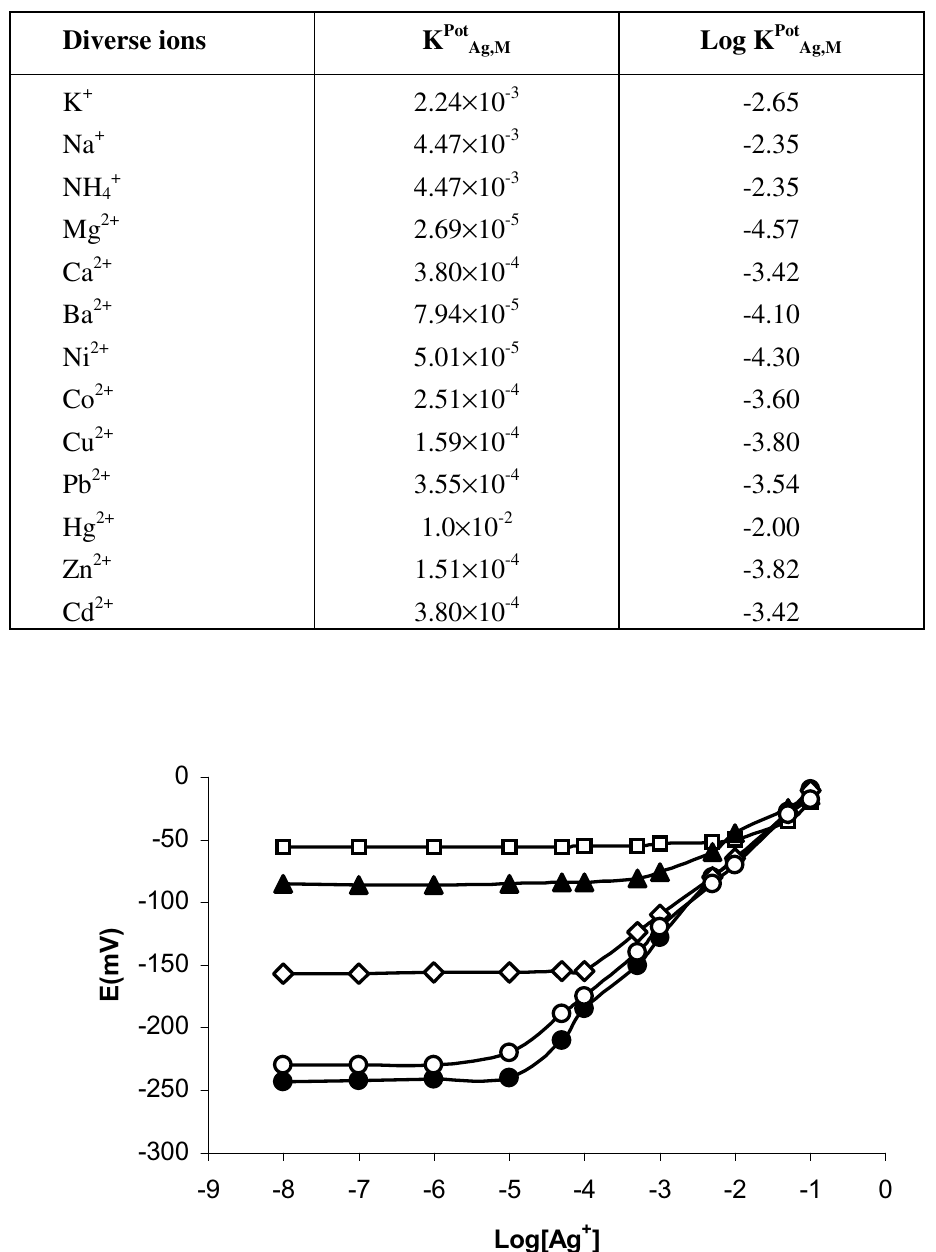
Table 1. The selectivity coefficients of diverse ions.